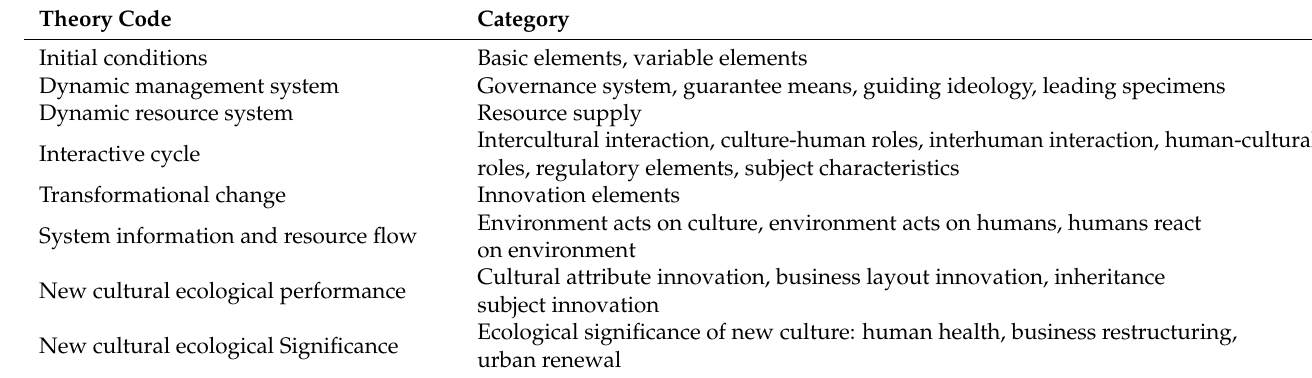
Table 4. Theoretical coding analysis results of Shiwan pottery sculpture technique’s effective text (all